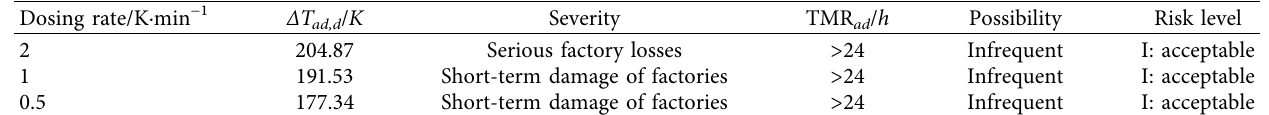
Table 4: Risk matrix for synthesis of Grignard reagent at different dosing rates.